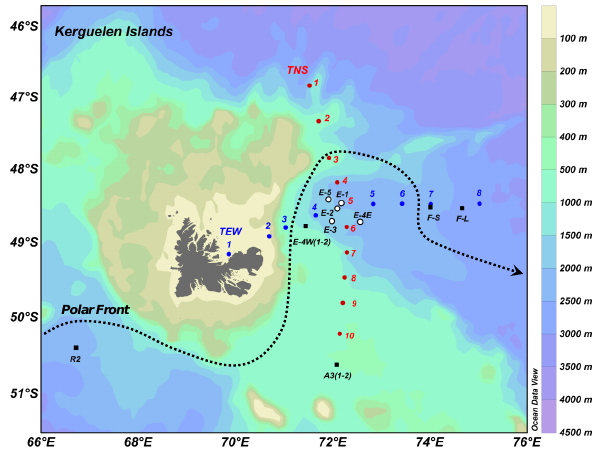
Figure 1 Figure 1. Location of the sampling stations. Transects from North to South (TNS) and from west to the east (TEW) are indicated in red and blue, respectively. The blank filled circles correspond to a time-series of a recirculation system (E-1, E-2, E-3, E-4E, and E- 5). The stations F-L and F-S are located in the eastern bloom in the polar front zone. A3 and E-4W are the reference southeastern Ker- guelen Plateau bloom and the reference eastern flank of the Ker- guelen Plateau, respectively. Both were visited twice (1–2). R2 is the HNLC reference station. The dotted line represents the approx- imate location of the southern branch of the polar